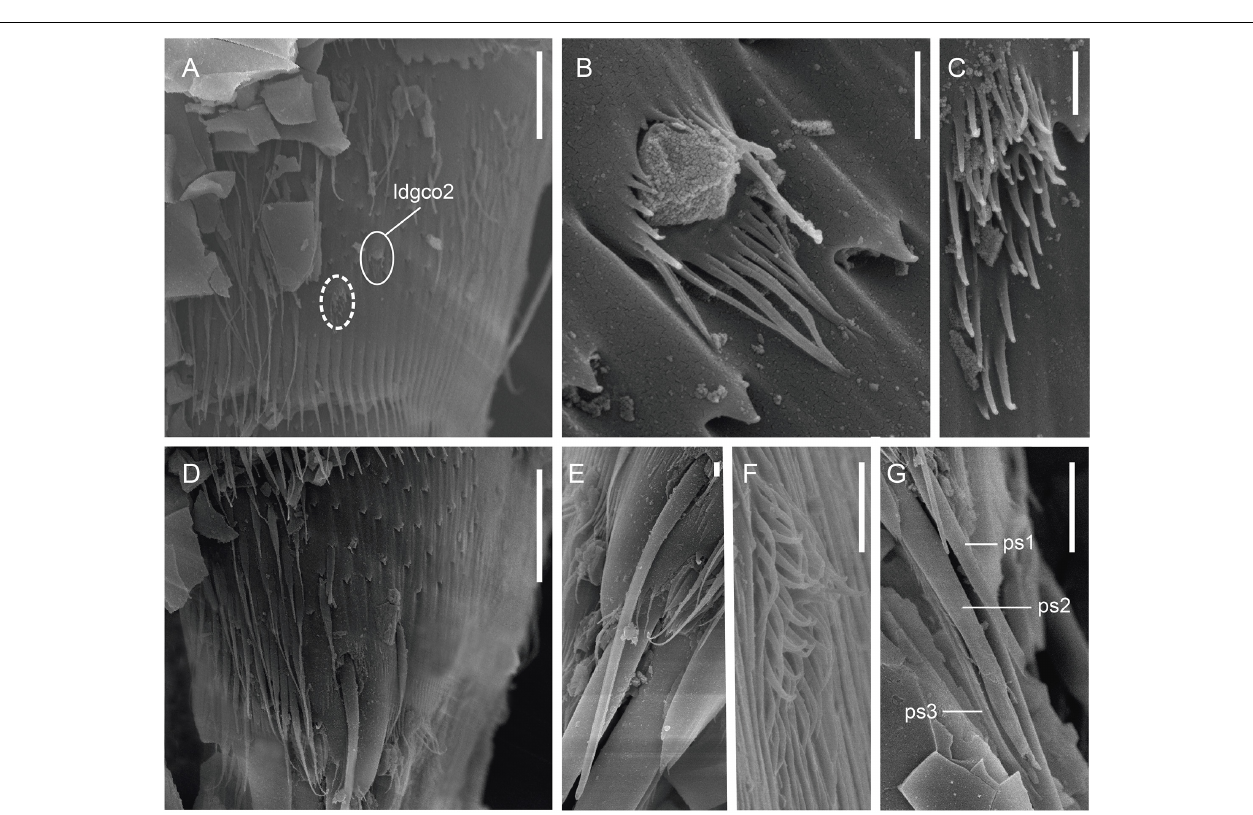
FIGURE 8 | Light micrographs showing trunk overview and details in the head, neck, and main trunk cuticular characters of female holotype NHMD 669727 (A–E,H,J) and male paratype NHMD 669728 (F,G,I,K) of Fissuroderes cthulhu sp. nov. (A) Dorsal overview of trunk; (B) neck and middorsal to midlateral view on right half of tergal plates of segments 1–2; (C) neck and sublateral to ventromedial view tergal and sternal plates of segments 1–2; (D) middorsal to midlateral view on right half of tergal plates of segments 3–6; (E) sublateral to ventromedial view on left half of tergal and sternal plates of segments 3–6; (F) mouth cone; (G) middorsal to midlateral view on right half of tergal plates of segments 8–9; (H) sublateral to ventromedial view on left half of tergal and sternal plates of segments 7–8; (I) middorsal to midlateral view on right half of tergal plate of segment 10; (J) lateral terminal accessory spine; (K) introvert. Scale bars: (A): 100 µ m; (B–K) : 20 µ m. Abbreviations: ct, cuticular thickening; dpl, dorsal placid; ep, end-piece of outer oral style; ldt, laterodorsal tube; ltas, lateral terminal accessory spine; lts, lateral terminal spine; lvs, lateroventral spine; lvt, lateroventral tube; mds, middorsal spine; mvpl, midventral placid; pa, female papilla; ps, penile spine (followed by number of corresponding pair); psc, primary spinoscalid; sc, regular-sized scalid; st, spinous tuft of outer oral style; tsc, trichoscalid; tsp, trichoscalid plate; vlt, ventrolateral tube; numbers after abbreviations indicate corresponding segment; sensory spots are marked as dashed circles, and glandular cell outlets as closed circles; arrows indicate the muscular scars with several perforations as microsculpture.